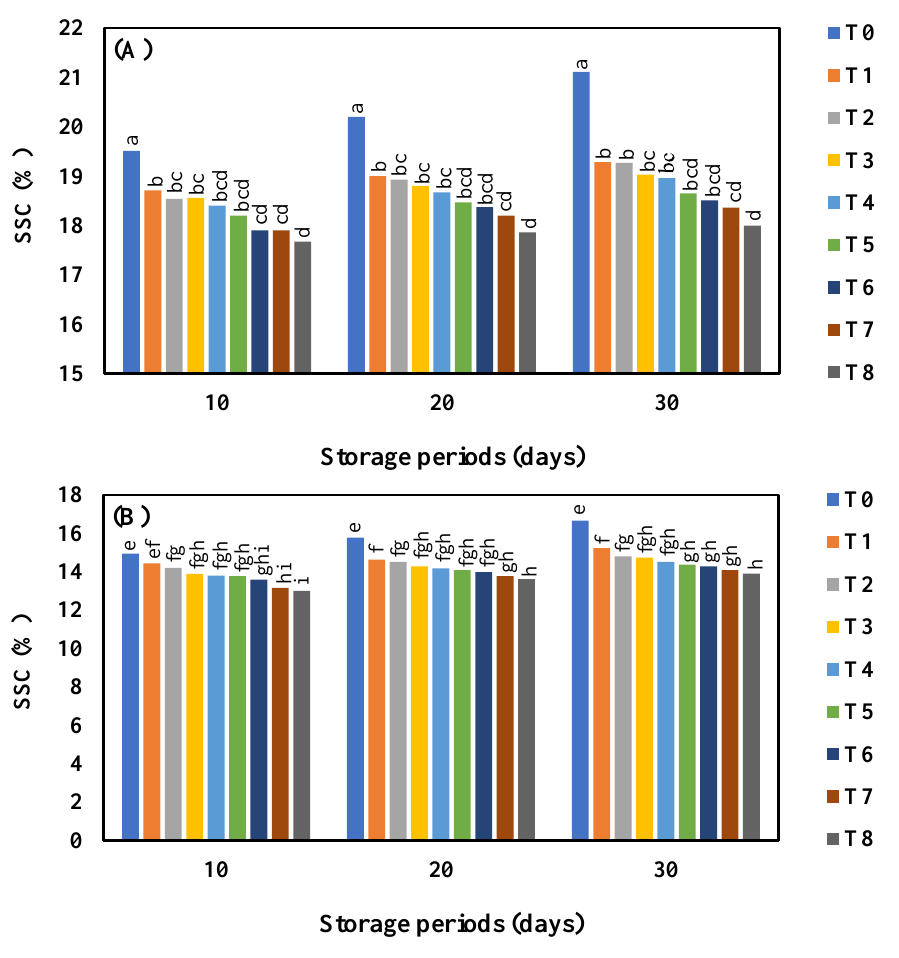
Figure 3. Effect of AgNO 3 and Ag-NPs on Soluble Solids Content (%) in Shine Muscat ( A ) and Kyoho ( B ) grape varieties during 30 days cold storage.